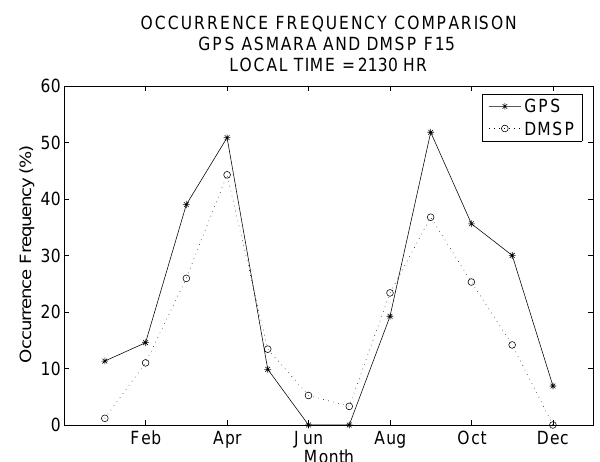
Fig. 6. Monthly average occurrence frequency comparison of Asmara GPS scintillation and DMSP EPB de- tection. Points are given at the start of the month for the whole month. The figure shows both satellite and ground-based agreement on the symmetry of equinoctial maxima.